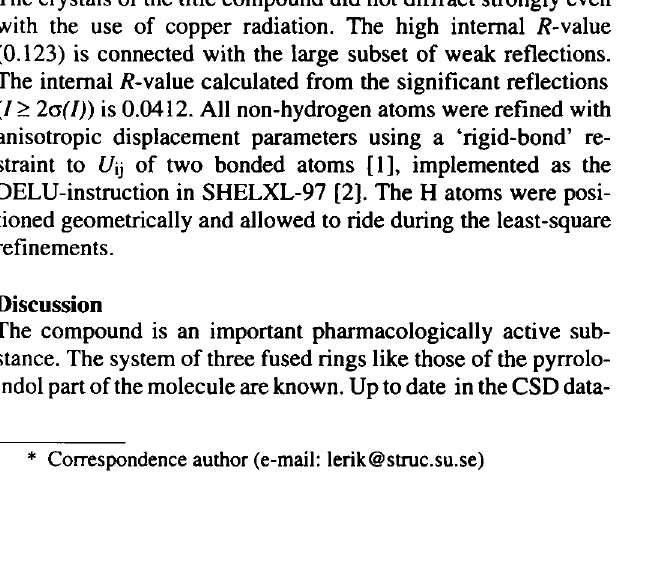
Table 2. Atomic coordinates and displacement parameters (in A 2